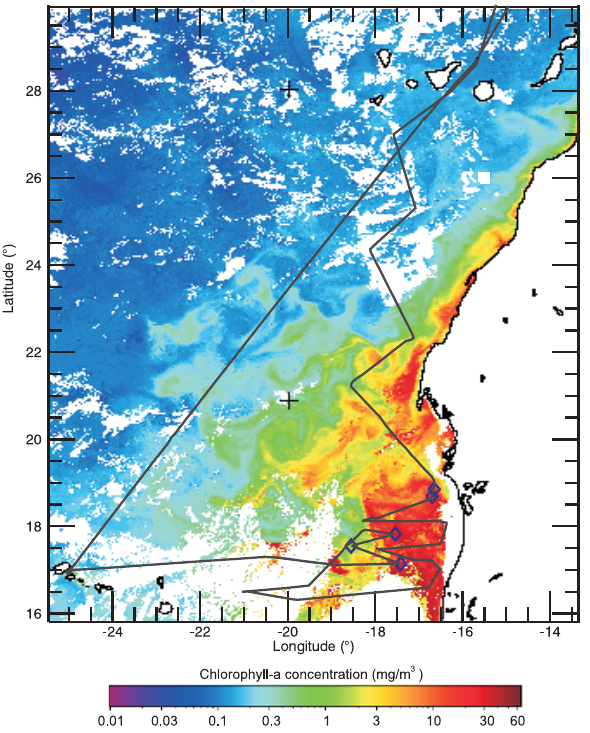
Fig. 1. RHaMBLe cruise track off the West coast of Africa overlaid on satellite chlorophyll image (SeaWiffs Ocean Color data) aver- aged over the cruise period on May–June 2007. Blue marks indi- cate the points at which seawater samples were collected for algal species